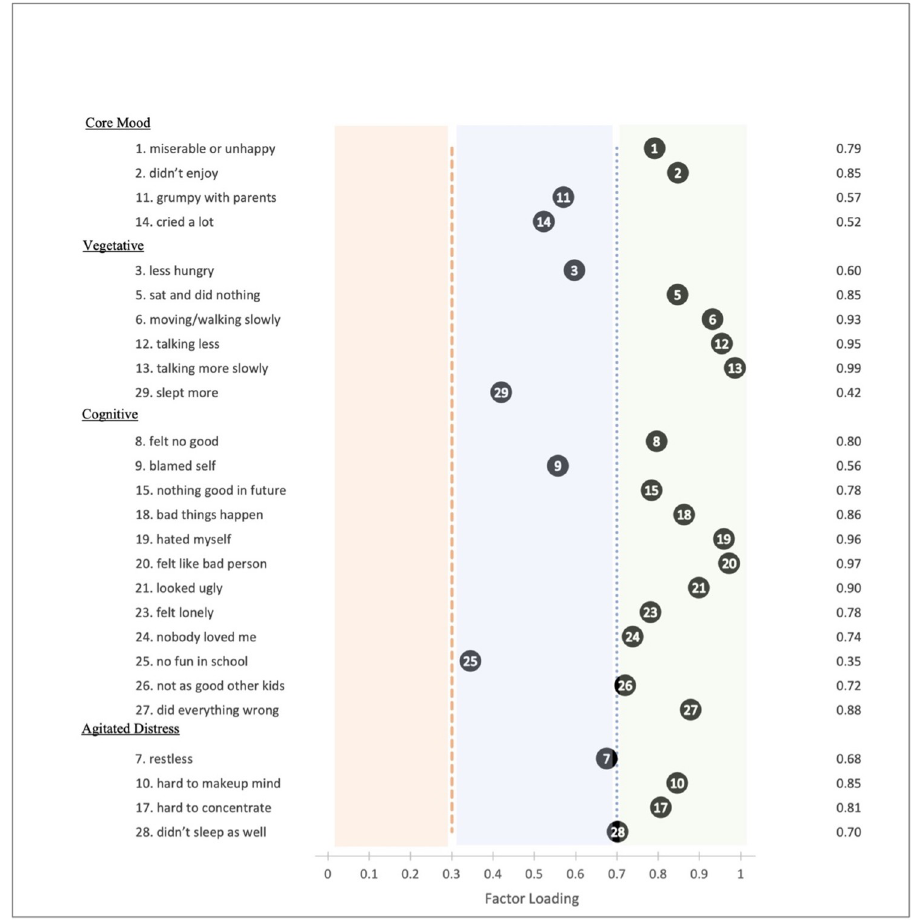
Fig 2. Factor loadings from the four-factor solution in confirmatory factor analysis applied to data obtained with the modified Mood and Feelings Questionnaire (child-version, 26-items).